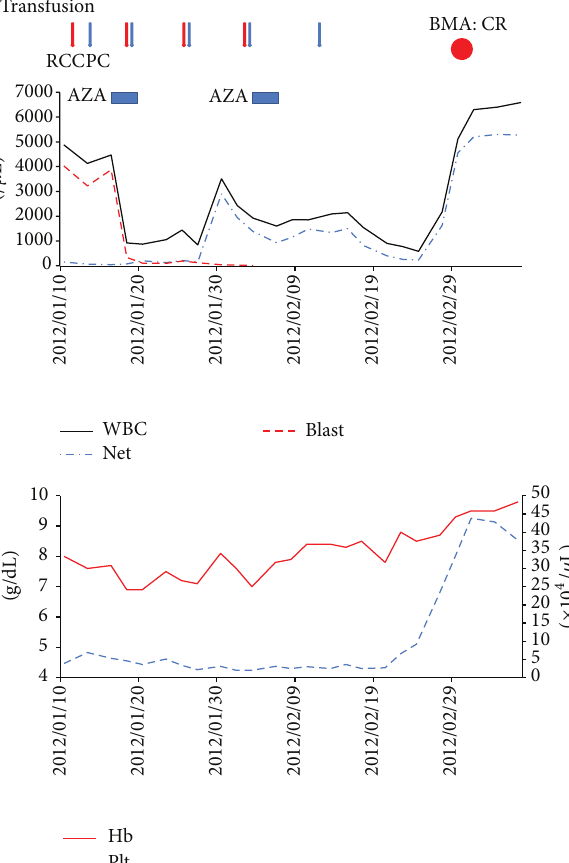
Figure 1: Clinical course after disease onset. RCC: red cell con- centrates, PC: platelet concentrates, Aza: azacitidine, BMA: bone marrow aspiration, CR: complete remission, WBC: white blood cells, Net: neutrophils, Hb: hemoglobin, and Plt: platelets.